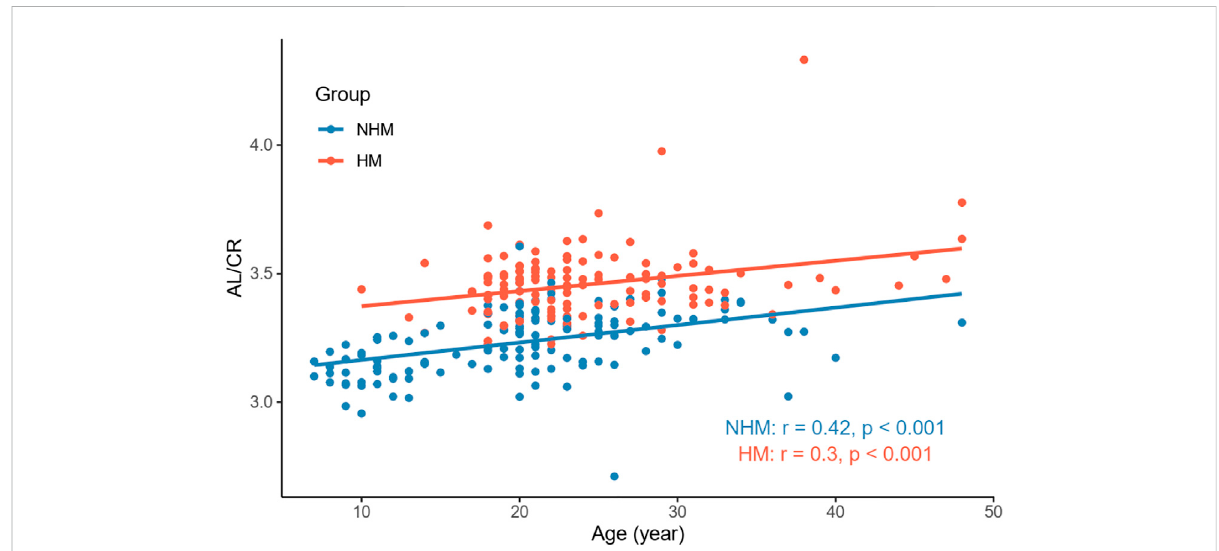
FIGURE 3 Relationship between age and AL/CR in the two groups. Age was associated with AL/CR in both the NHM ( r = 0.42, p < 0.001) and HM ( r = 0.3, p < 0.001) groups. Abbreviation: NHM, non-high myopia; HM, high myopia; AL/CR: axial length/corneal radius of curvature ratio.